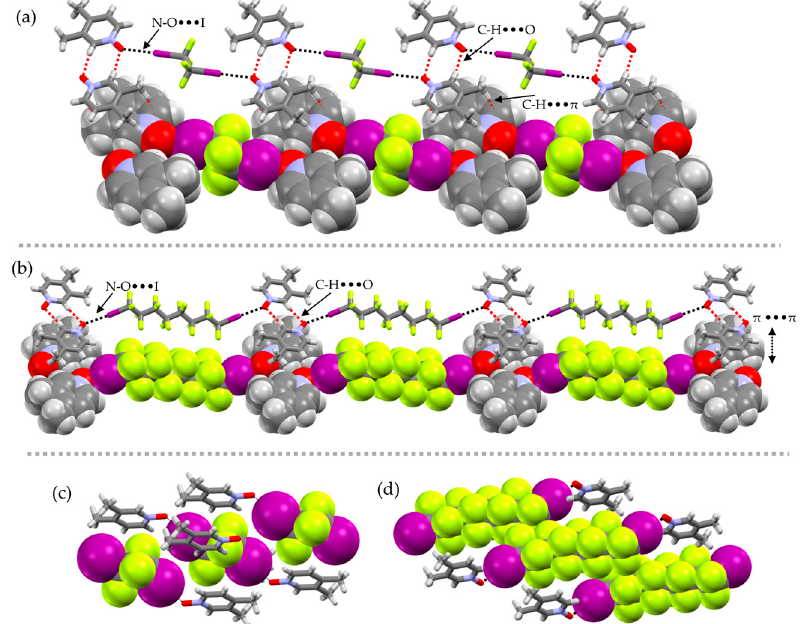
Figure 5. 1-D Chains propagated by alternating XB and C − H···O interactions in 7•DI2 ( a ) and 7•DI8 ( b ). Section of crystal packing displaying isolated DI2 in 7•DI2 ( c ), and partially F···F stabilized DI8 in 7•DI8 ( d ). Black and red broken lines are respectively XB and HB interactions.